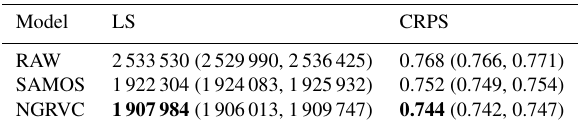
Figure 4. PIT histograms by pressure ranges for the probability dis- tributions of the raw ensemble (left), the NGRVC-postprocessed en- semble (middle) and the SAMOS-postprocessed ensemble (right). Bottom row 1020–850hPa, middle row 850–700hPa and top row 700–400hPa for all stations and all launch times combined. Solid horizontal lines show perfect calibration and the dotted lines are the 95% consistency interval thereof. Table 1. Out-of-sample negative logarithm of the likelihood (LS) and CRPS of the raw ensemble (RAW), SAMOS and NGRVC prob- ability distributions for all stations combined. Numbers in brack- ets give the 5th and 95th percentiles of the bootstrapped scores; they represent the 90% confidence intervals. Bold font indicates the models that performed